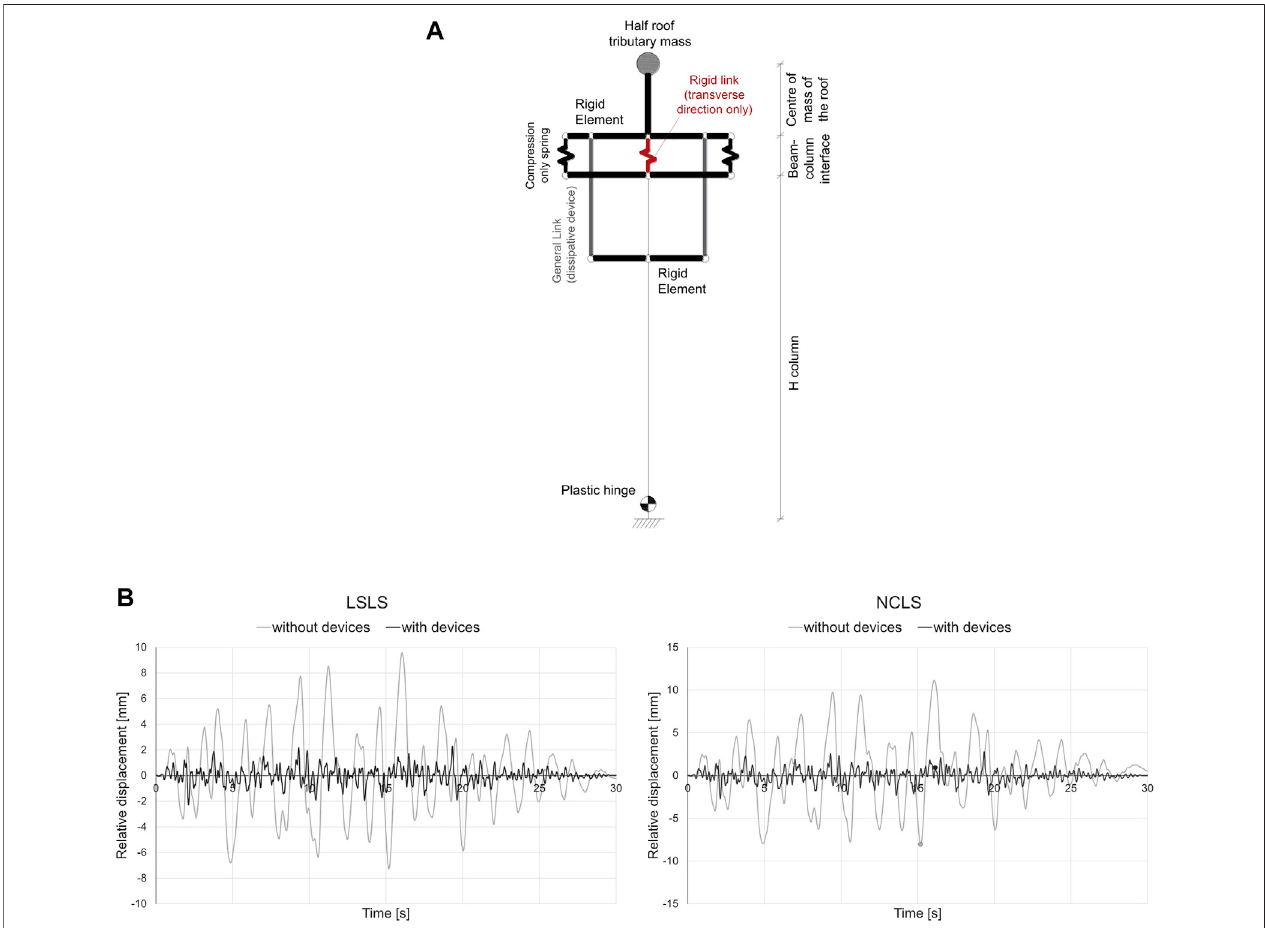
FIGURE 14 | Schematic view of the fi nite element model (A) and response history results of the out-of-plane analysis in terms of device relative displacement (B) .